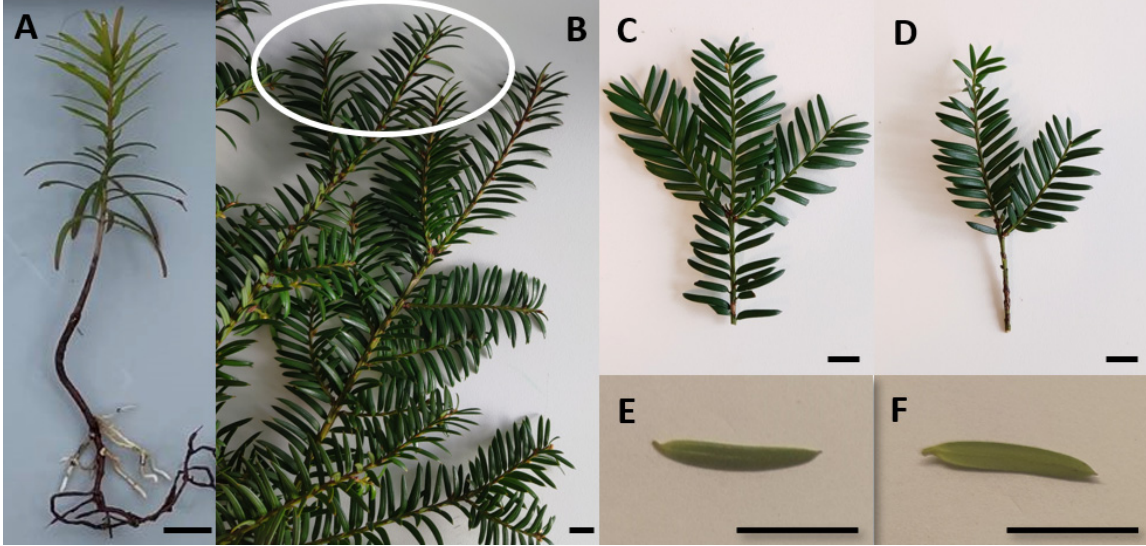
Figure 1. Plant material obtained from wild T. baccata seedlings and domesticated trees. ( A ) T. baccata seedling collected from a garden; ( B ) T. baccata branch collected from a garden. The white circle surrounding the sample of plant material selected for the preparation of both the shoot and needles. ( C ) Specimen of a young shoot explant. ( D ) Specimen of a young shoot explant after discarding the needles from approximately 3 cm from shoot base. ( E ) Adaxial side of a needle selected as an explant. ( F ) Abaxial side of a needle selected as an explant. Both sides of the needle were green and free of contamination. Bars = 1